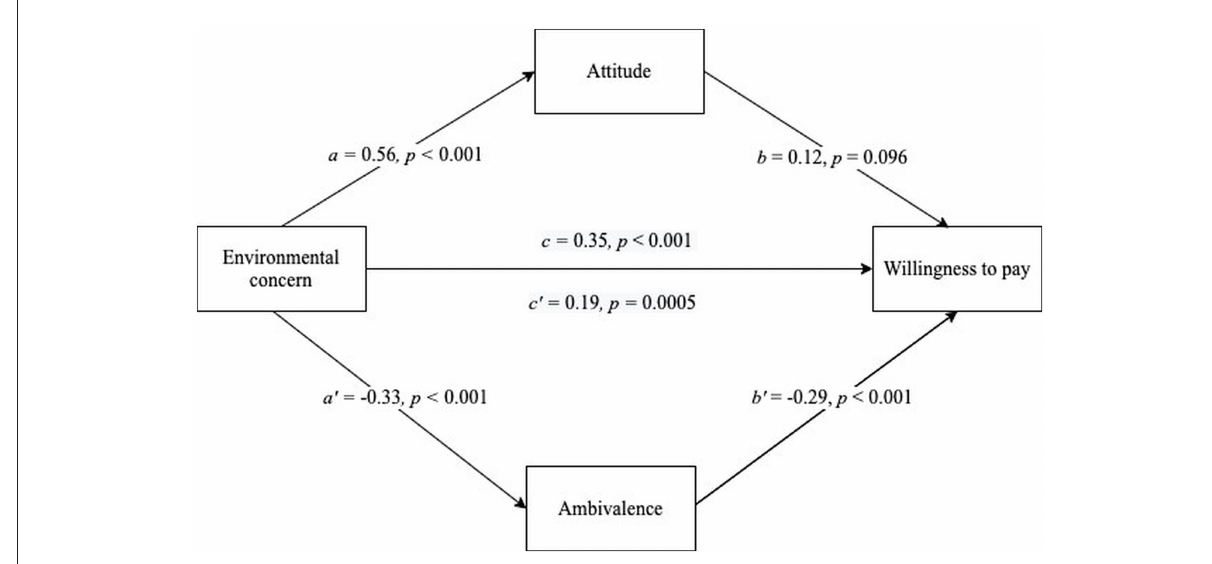
FIGURE4 Parallel mediation analysis visualising the effect of environmental concerns on WTP for suboptimal food mediated by attitudes towards suboptimal food and